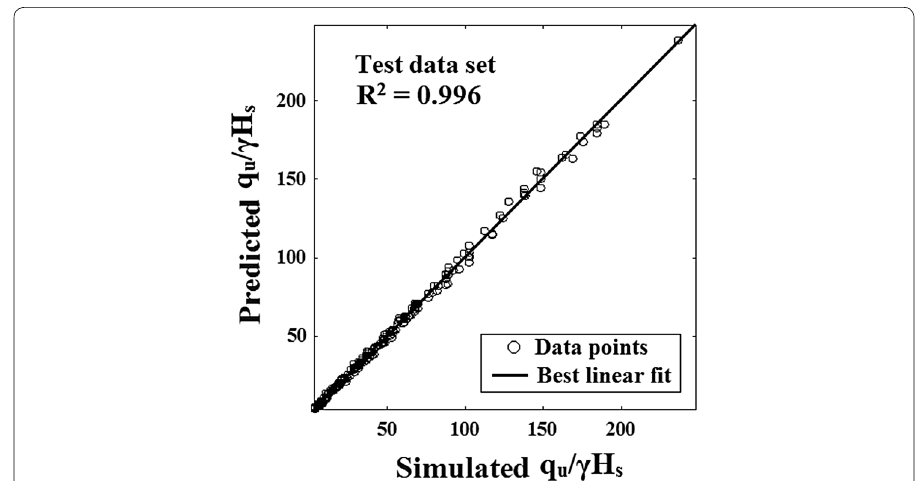
Fig. 17 Performance of neural network model for testing